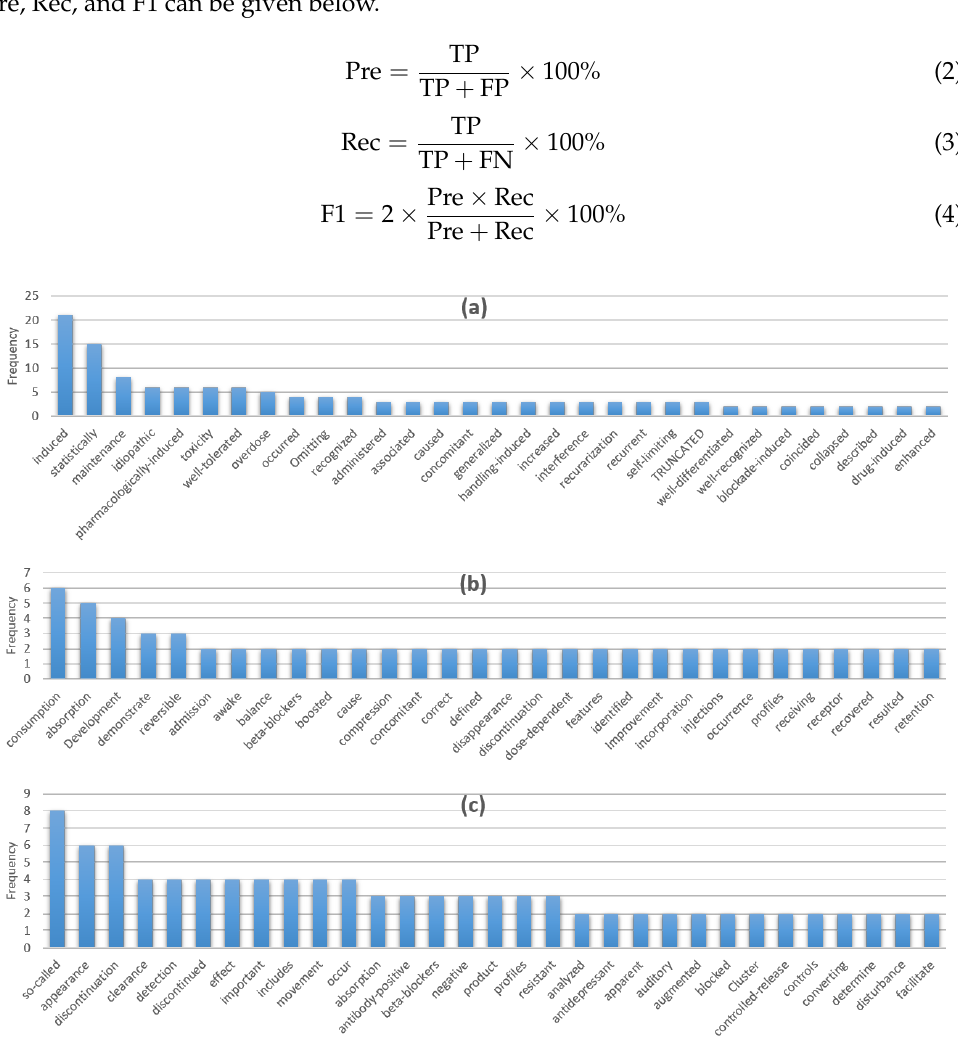
Figure 4. Keyword frequency. Subfigures ( a – c ) correspond to the tokens resulting in the most, second-most, and third-most confidence